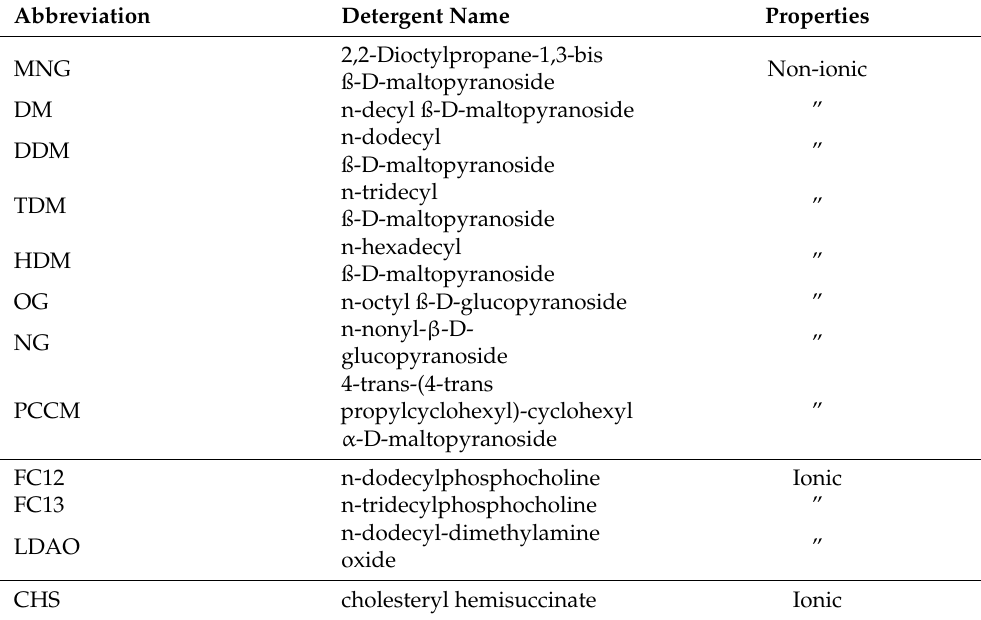
Table 1. Detergents used in the screening